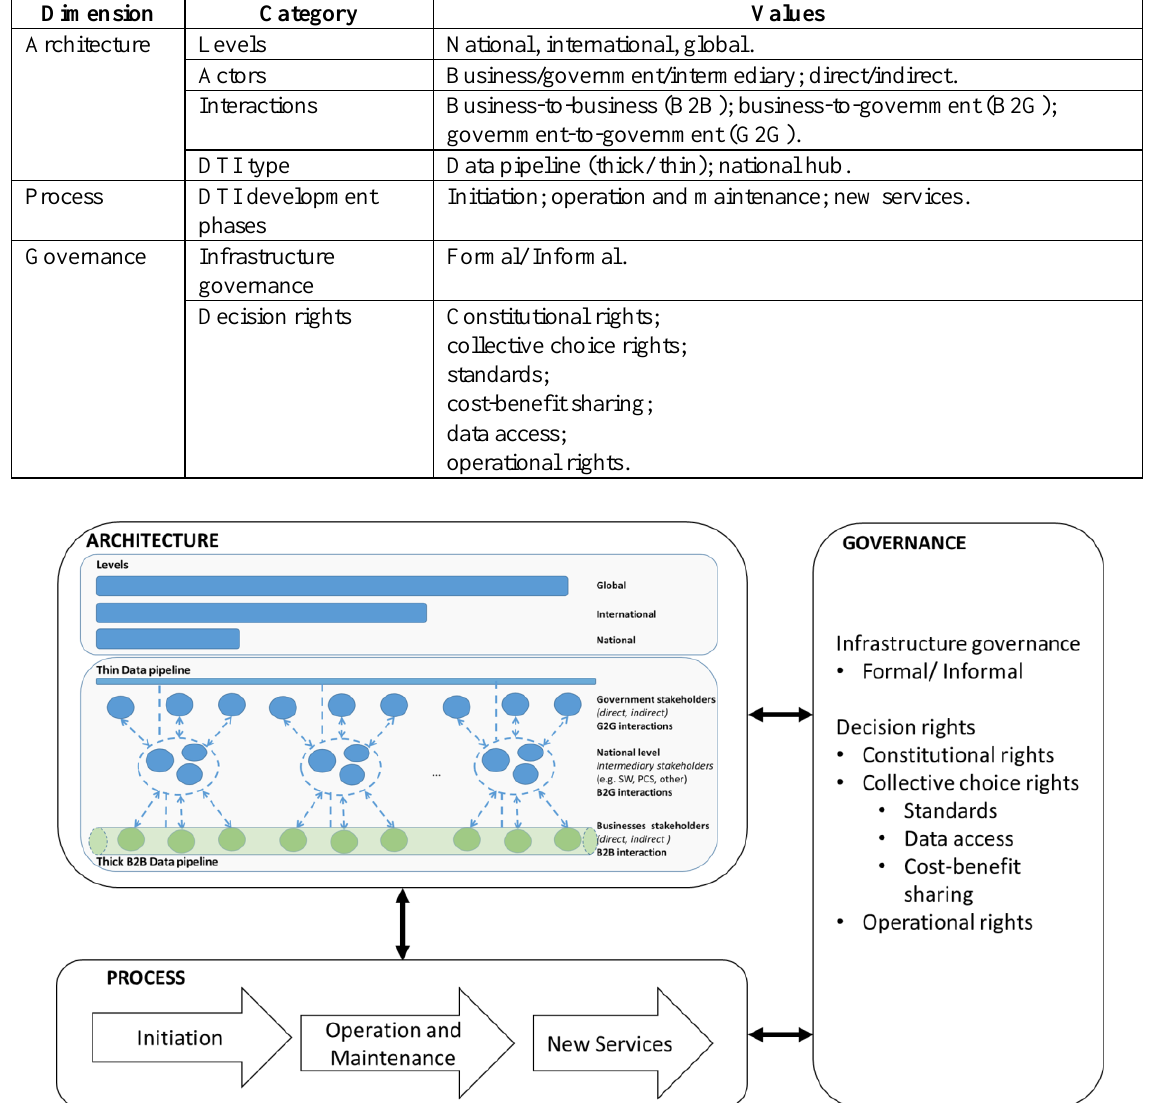
Figure 1. Visualization of the DTI